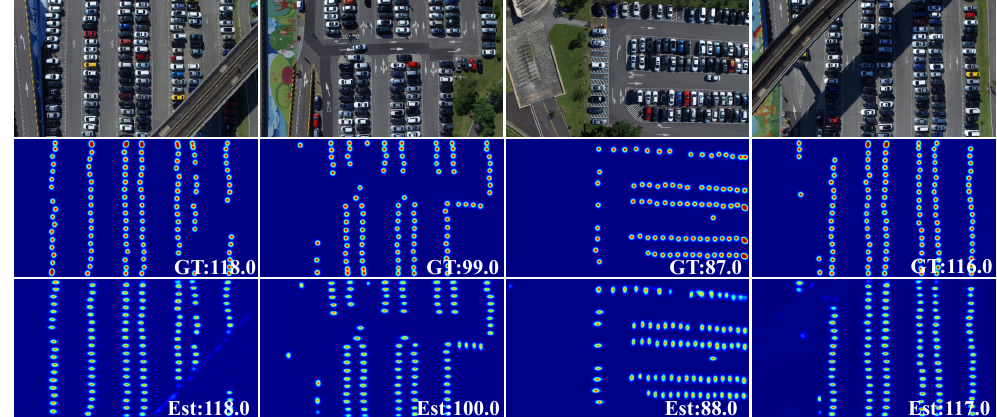
Figure 10. Subjective results on the CARPK dataset.